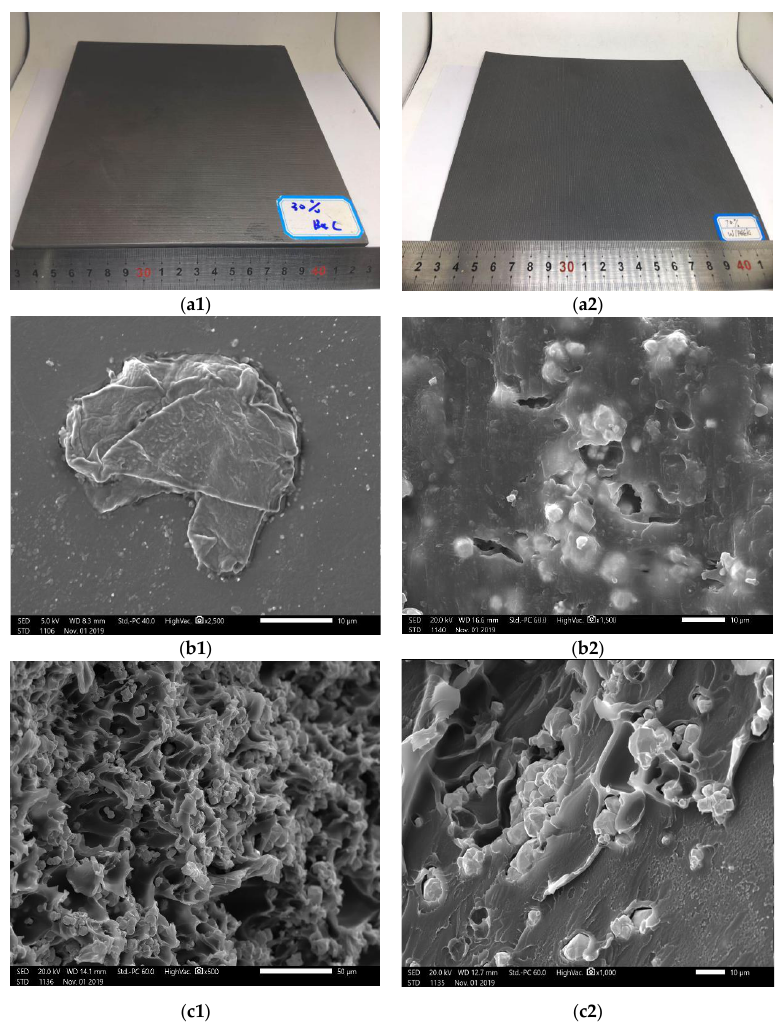
Figure 17. PEEK composite test pieces: ( a1 ) 30 wt.% PEEK/boron carbide shielding body, ( a2 ) 70 wt.% PEEK/tungsten shielding body, ( b1 ) electron micrograph of 30 wt.% PEEK/boron carbide shielding body layer surface (×2500), ( b2 ) electron micrograph of 70% PEEK/boron carbide shielding body layer surface (×1500), ( c1 ) electron micrograph of broken section of 70 wt.% PEEK/tungsten shielding body (×500), and ( c2 ) electron micrograph of broken section of 70 wt.% PEEK/tungsten shielding body (×1000).